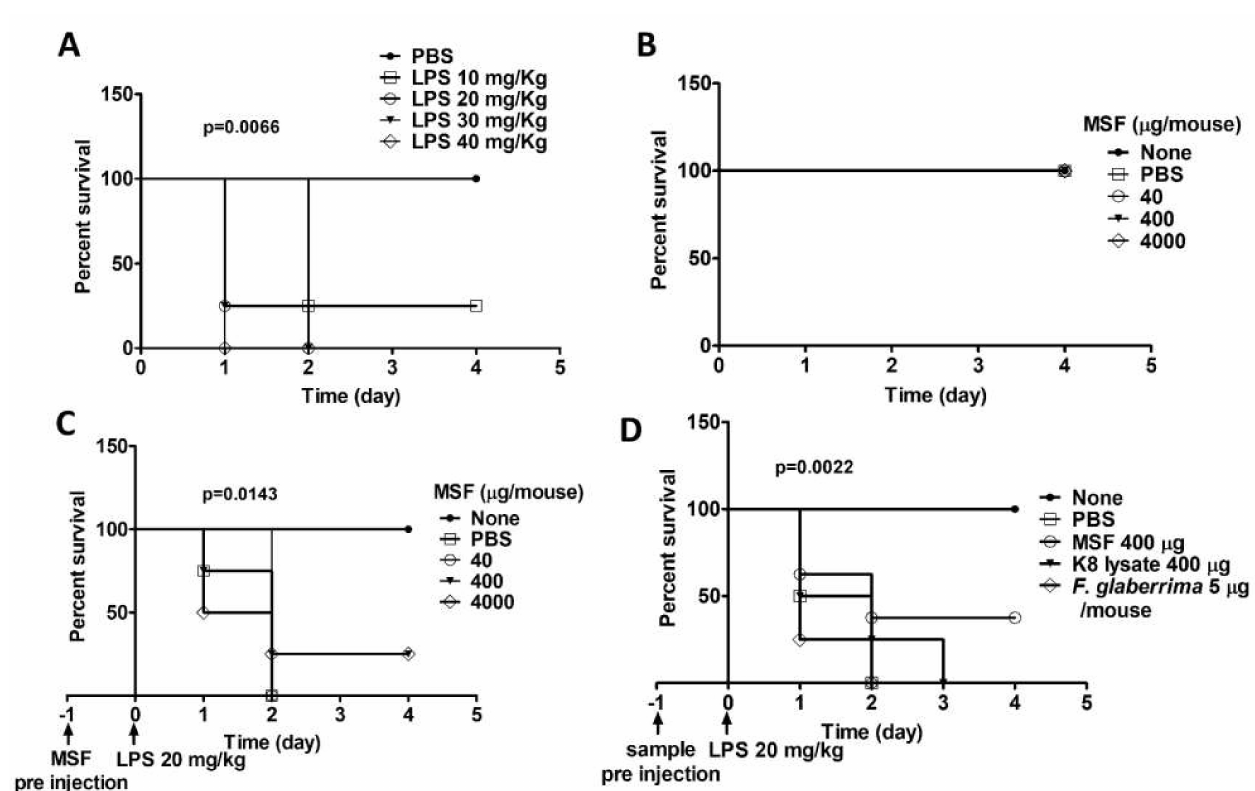
Figure 6. MSF decreased LPS-induced mouse mortality. ( A ) BALB/c mice (7 weeks old, 8 mice/group) were intraperitoneally (i.p.) injected with LPS at the indicated concentration. ( B ) Mice (n = 8) were i.p. injected with MSF at the indicated concentration. ( C ) Mice (n = 8) were i.p. pre-injected with MSF at the indicated concentration for 24 h and then re-injected with 20 mg/kg LPS. ( D ) Mice (n = 8) were i.p. pre-injected with PBS, 400 µ g/mouse MSF, 400 µ g/mouse K8 lysates, or 5 µ g/mouse F. glaberrima extracts for 24 h and then re-injected with 20 mg/kg LPS. Mouse mortality was observed for 5